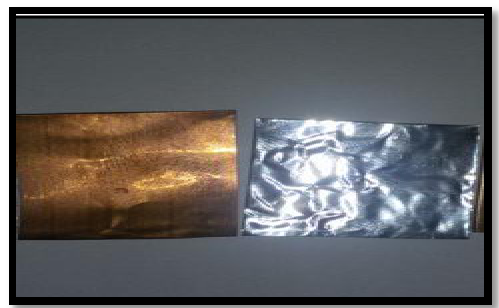
Fig.1: Aluminum and copper foils that used in this work.